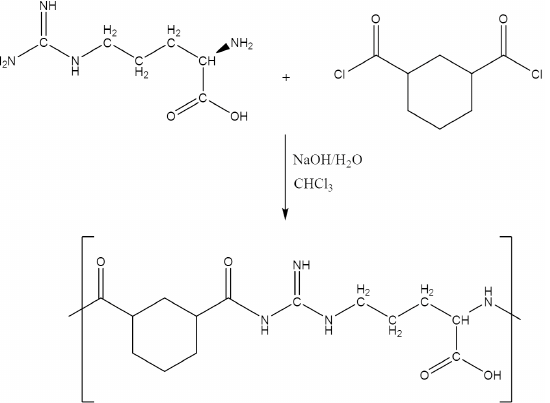
Figure 1. Synthesis of the polyamide by interfacial polycondensation of L -arginine amino acid and cis/trans-1,3-cyclohexane dicarbonyl chloride.